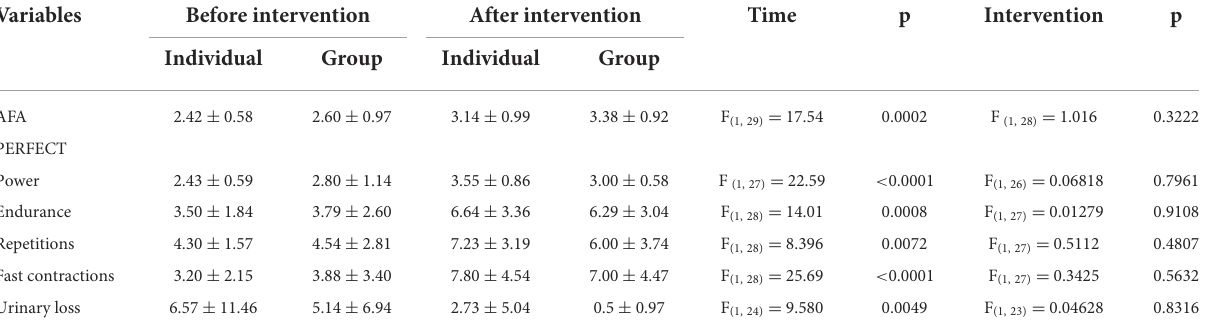
TABLE 2 Results of repeated-measures ANOVAs measuring ( n =